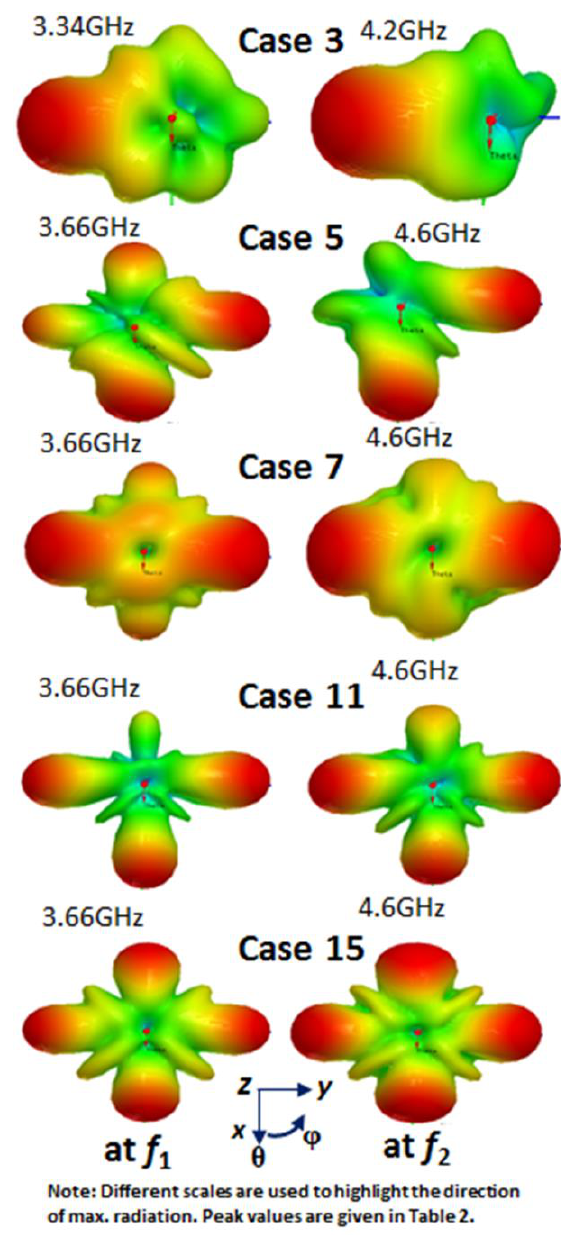
Figure 8: Simulated 3D radiation